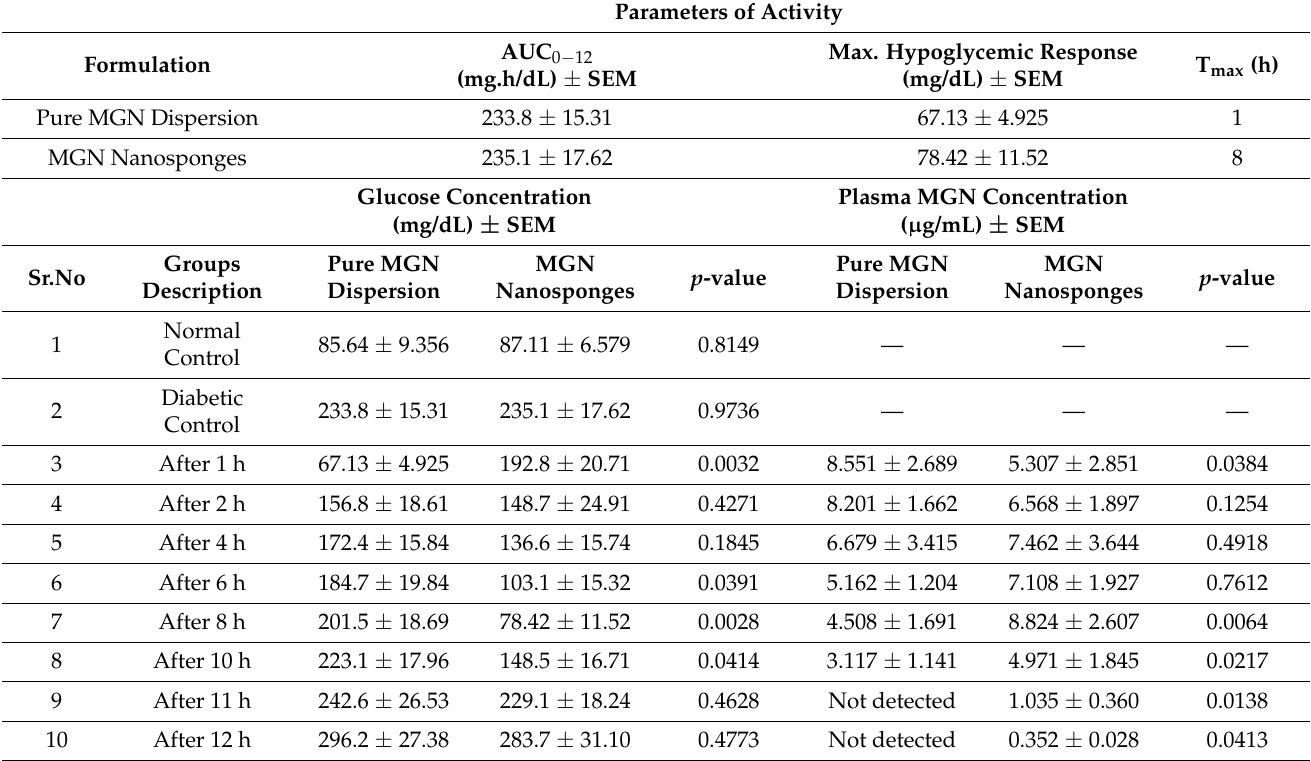
Figure 3. Plasma concentration in experimental rats after administration of pure MGN and MGN nanosponges ( A ), and plasma glucose concentration in experimental rats after administration of pure MGN and MGN nanosponges in different time intervals ( B ). Table 2. Data of in vivo pharmacokinetic model of pure and MGN loaded nanosponges. Parameters of Activity